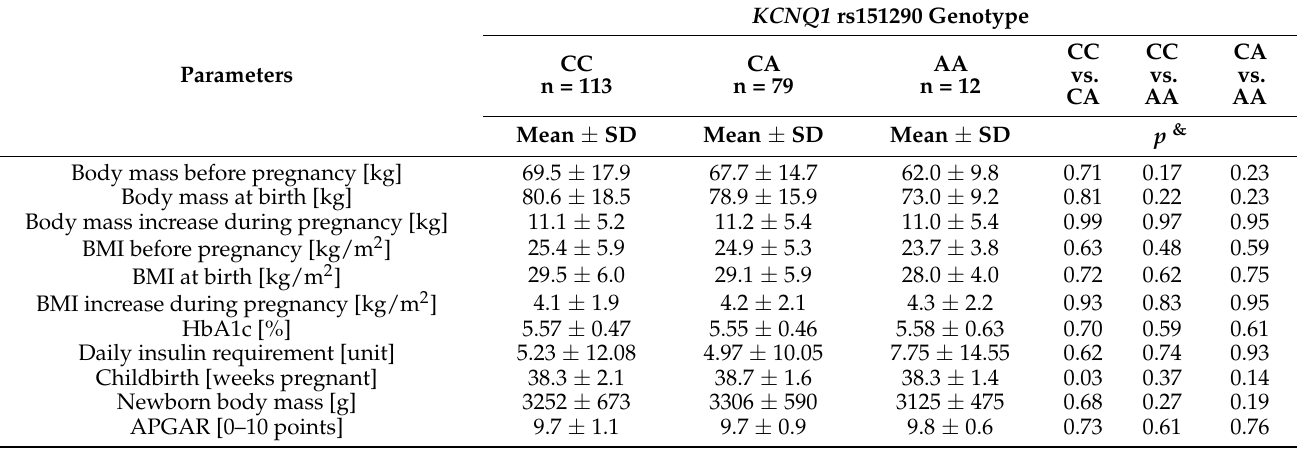
Table 6. Clinical parameters of women with GDM stratified according to KCNQ1 rs151290 genotype.